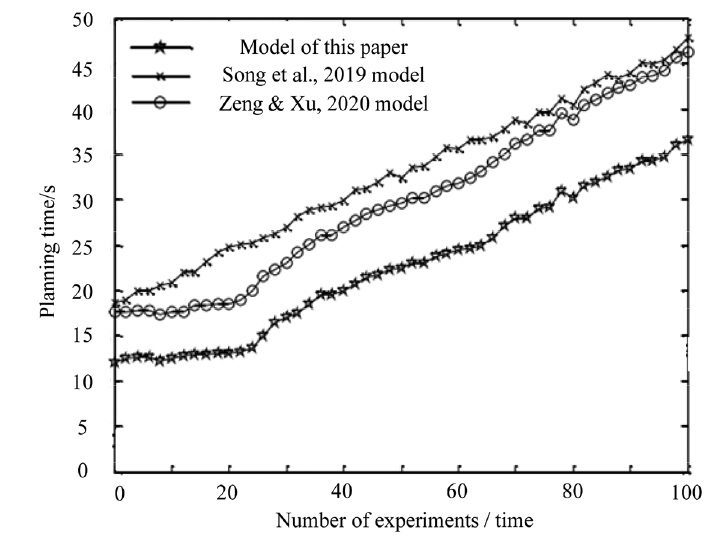
Figure 2. Comparison results of planning